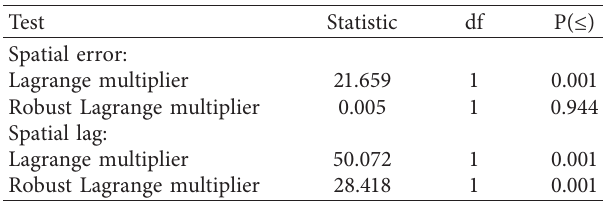
Table 4: LM test